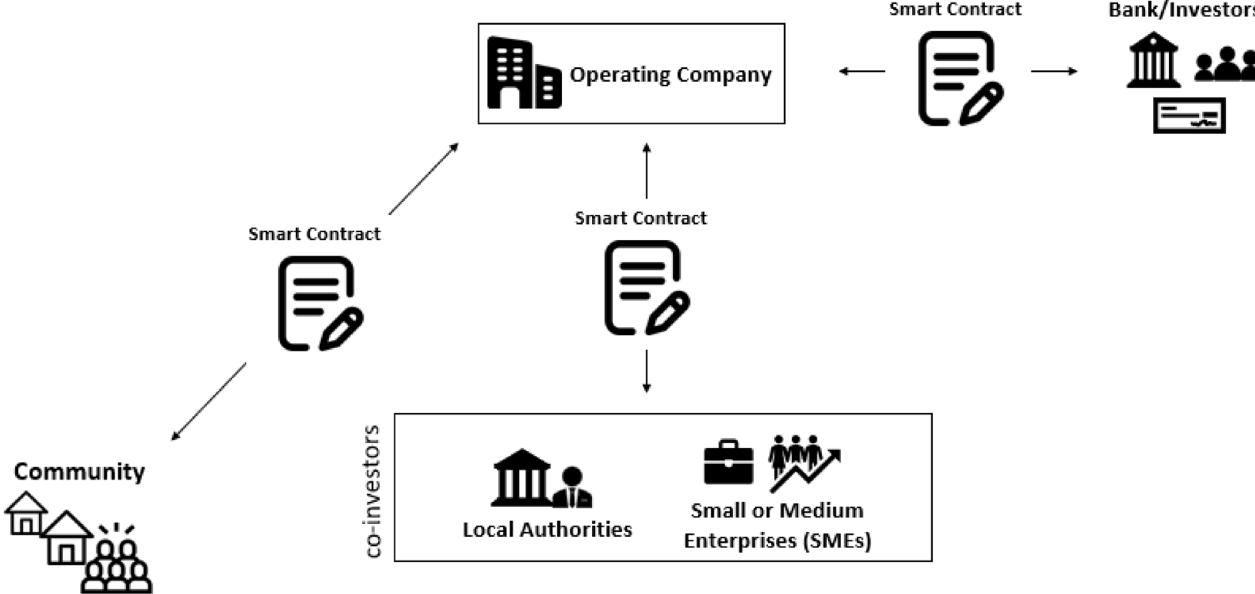
Fig. 3. Possible implementation of smart